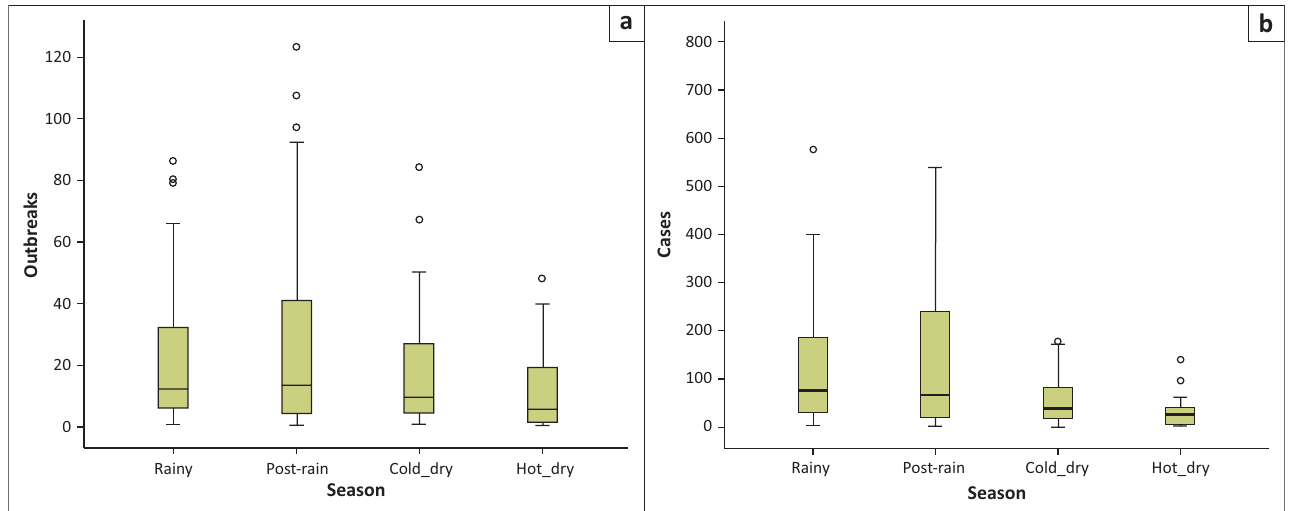
FIGURE 3: Seasonal distribution of dermatophilosis (a) outbreaks and (b) cases for the period